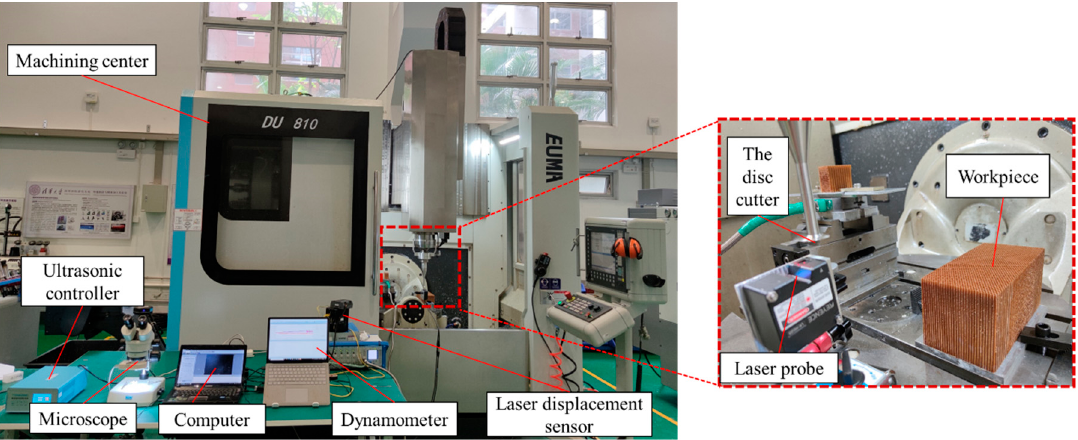
Figure 6. The experimental platform.